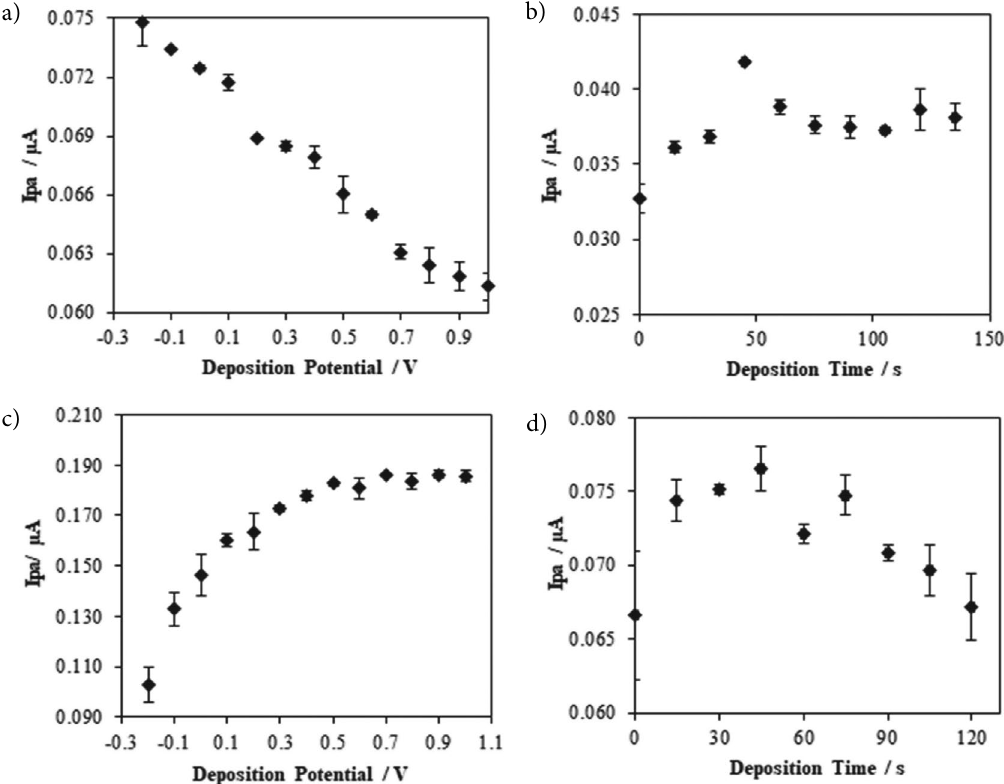
Fig. 6 a . The effect of the deposition potential on the peak current. b . the effect of deposition time on peak current using AdsDPV. c . and d . the graphs obtained using AdsSWV (3.0 × 10 –5 molL –1 HQ in 0.04 molL –1 BR buffer pH